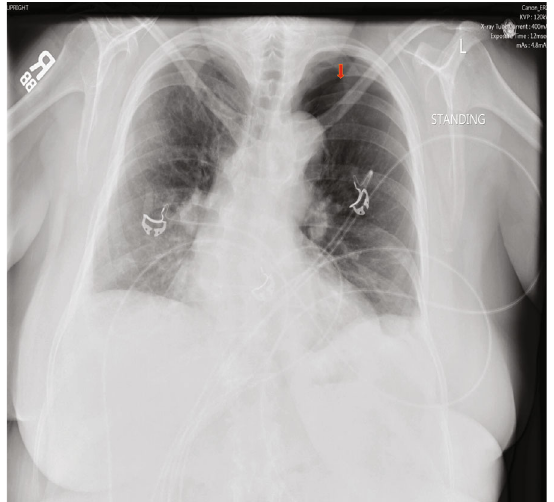
Figure 4: Chest X-ray showing large left-sided pneumothorax (depicted by red